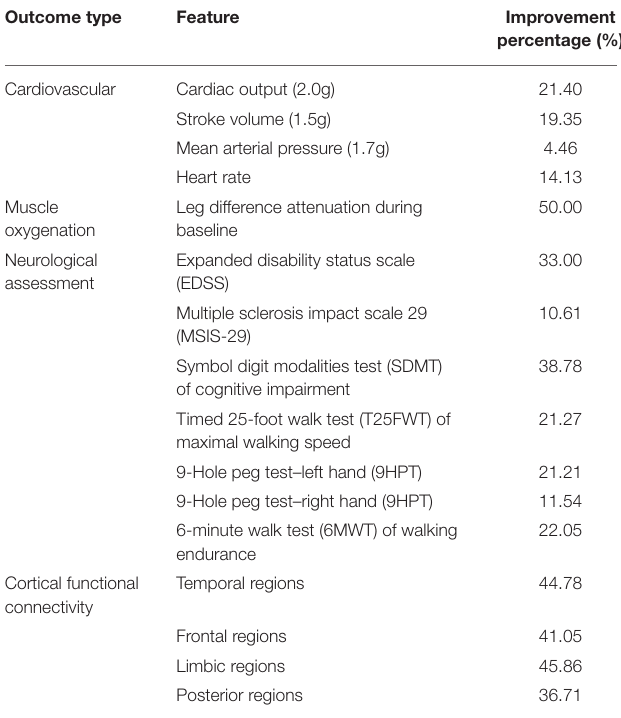
TABLE 5 | Improvement percentage (%) of the outcome measures after